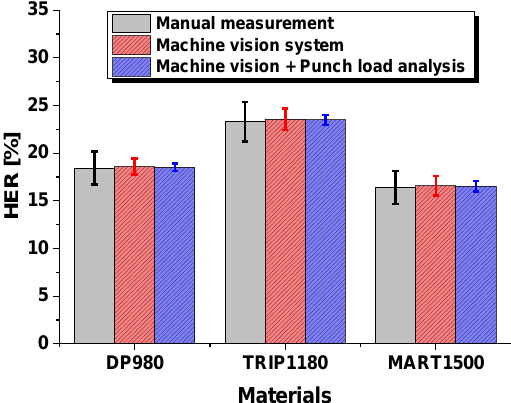
Figure 12. Experimental results by HER evaluation method in hole expansion test .